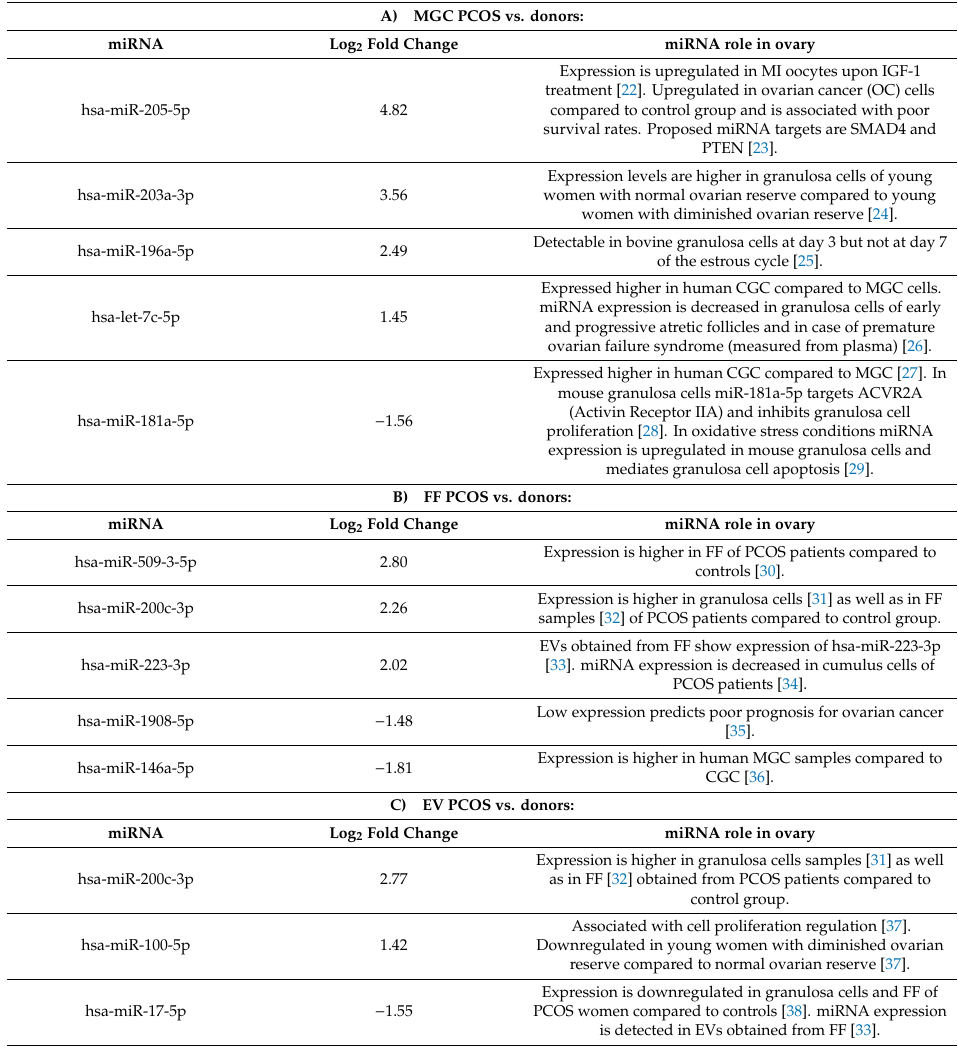
Table 2. Di ff erentially expressed miRNAs between PCOS patients and oocyte donor samples selected for RT-qPCR